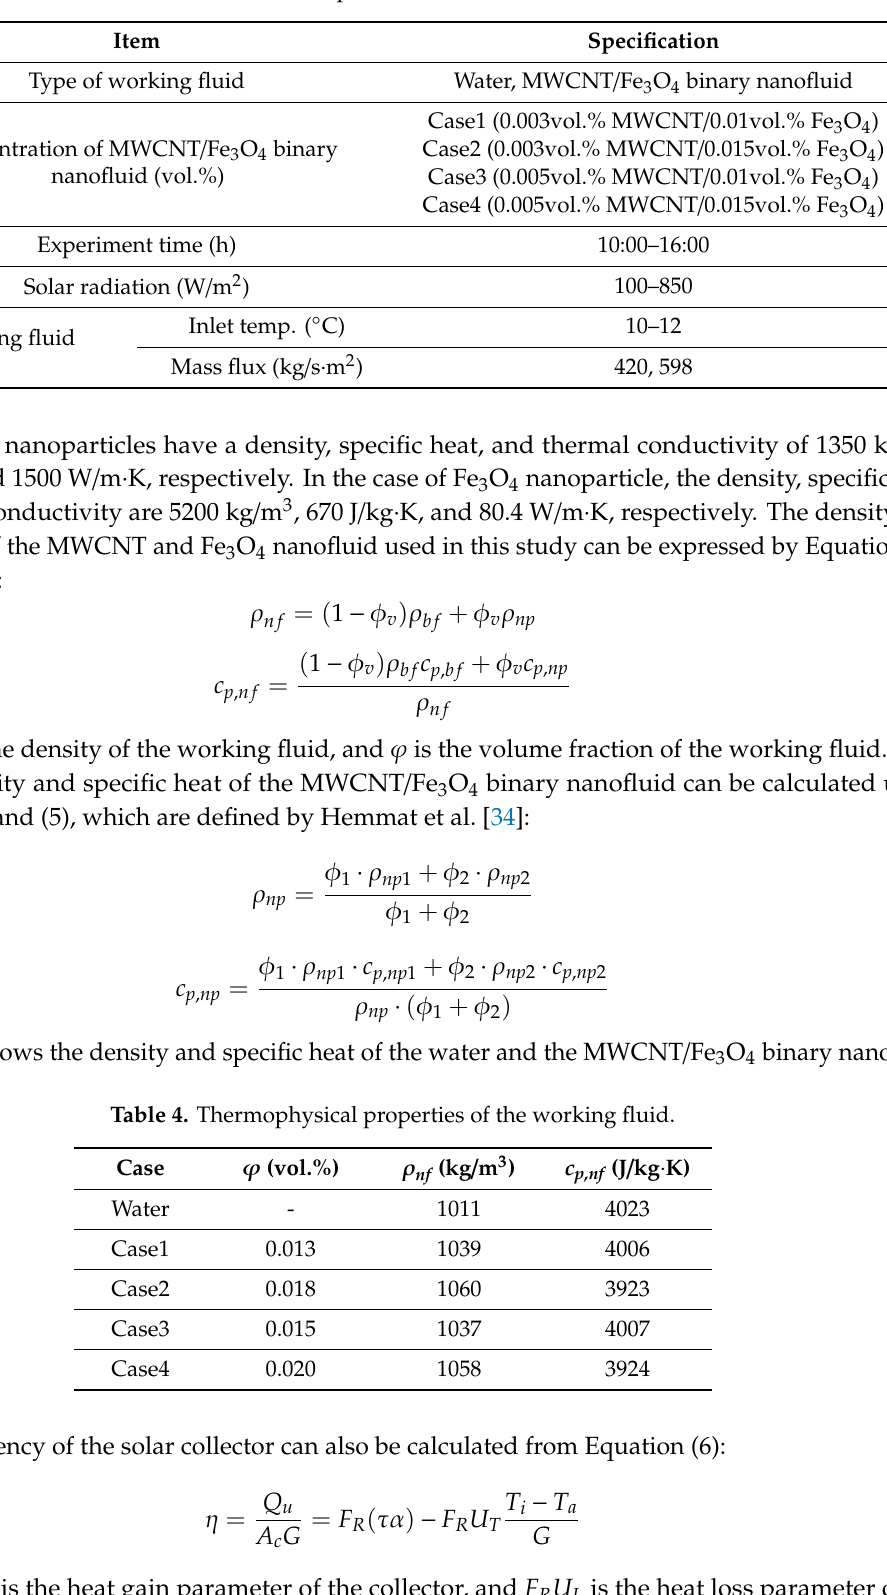
Table 3. Experimental conditions.